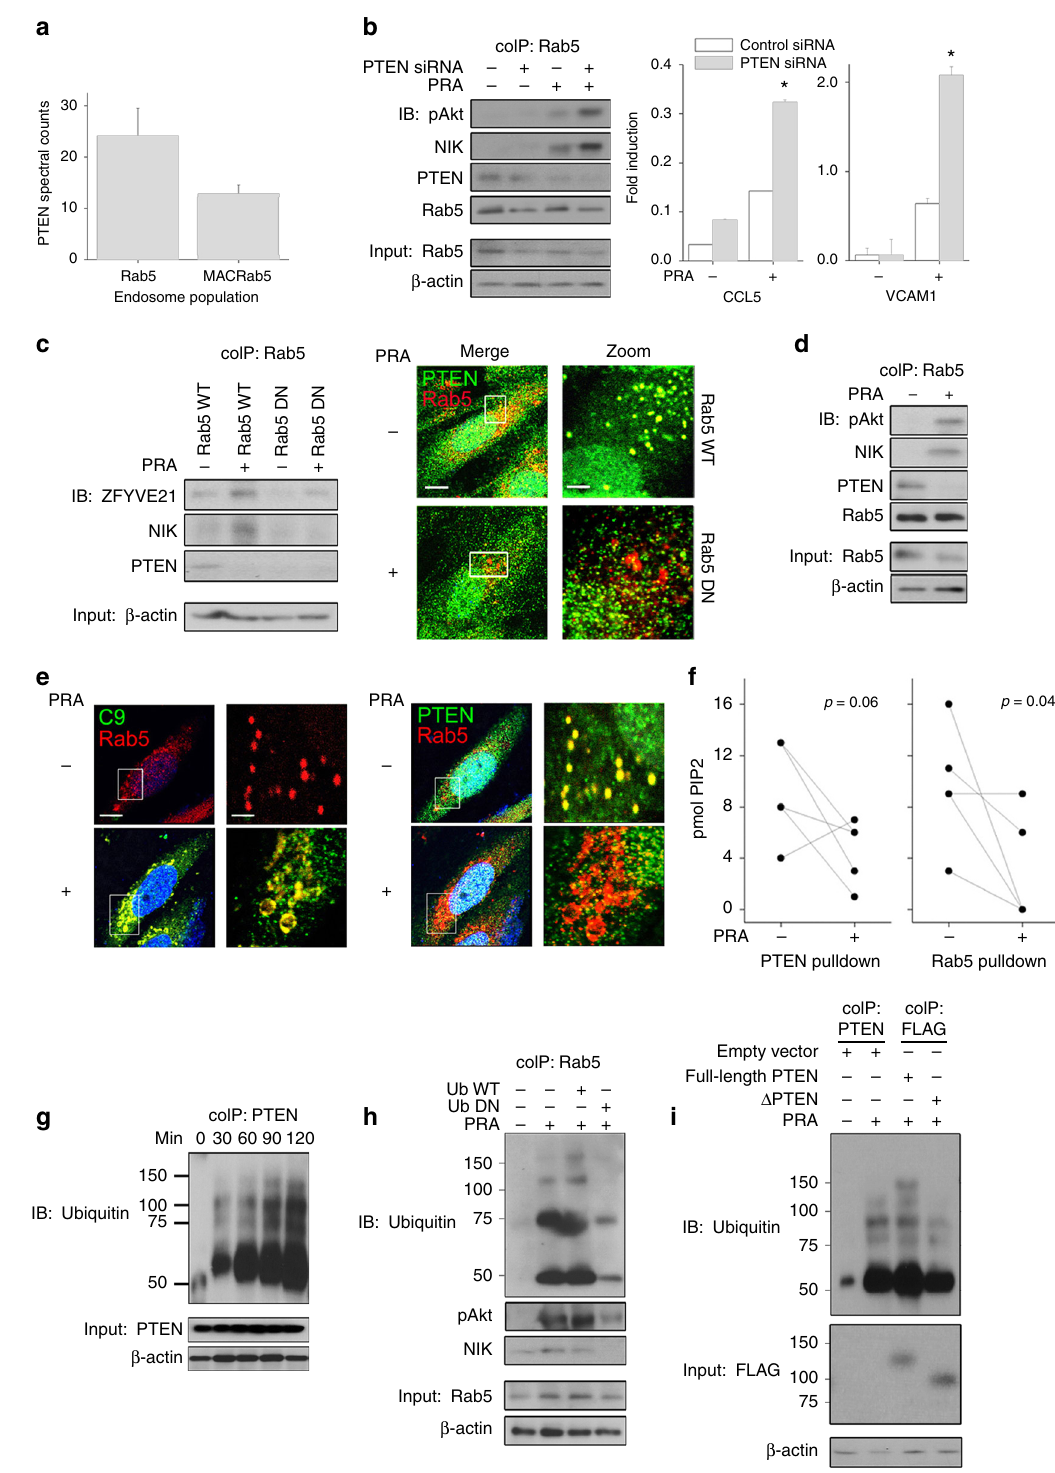
(Fig. 3h), implicating proteasomes but not lysosomes as the predominant degradative mechanism for PTEN. Cumulatively, these data indicated that ZFYVE21-mediated recruitment of SMURF2 promotes proteasome-mediated degradation of vesicle- associated PTEN to alter endosomal PI composition to favor pAkt